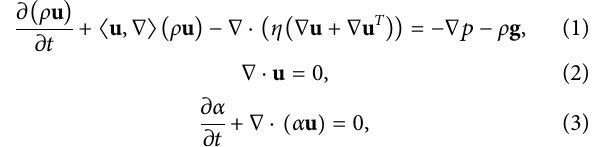
FIGURE 2 | The cumulative volume of the growing lava dome (A) , averagedischargerate (B) ,andthenumberofexplosiveevents (C) ,wherethe maximum likelihood regression lines (blue) present variations in the number of explosions. Source data: Zobin et al. (2015; 2017).